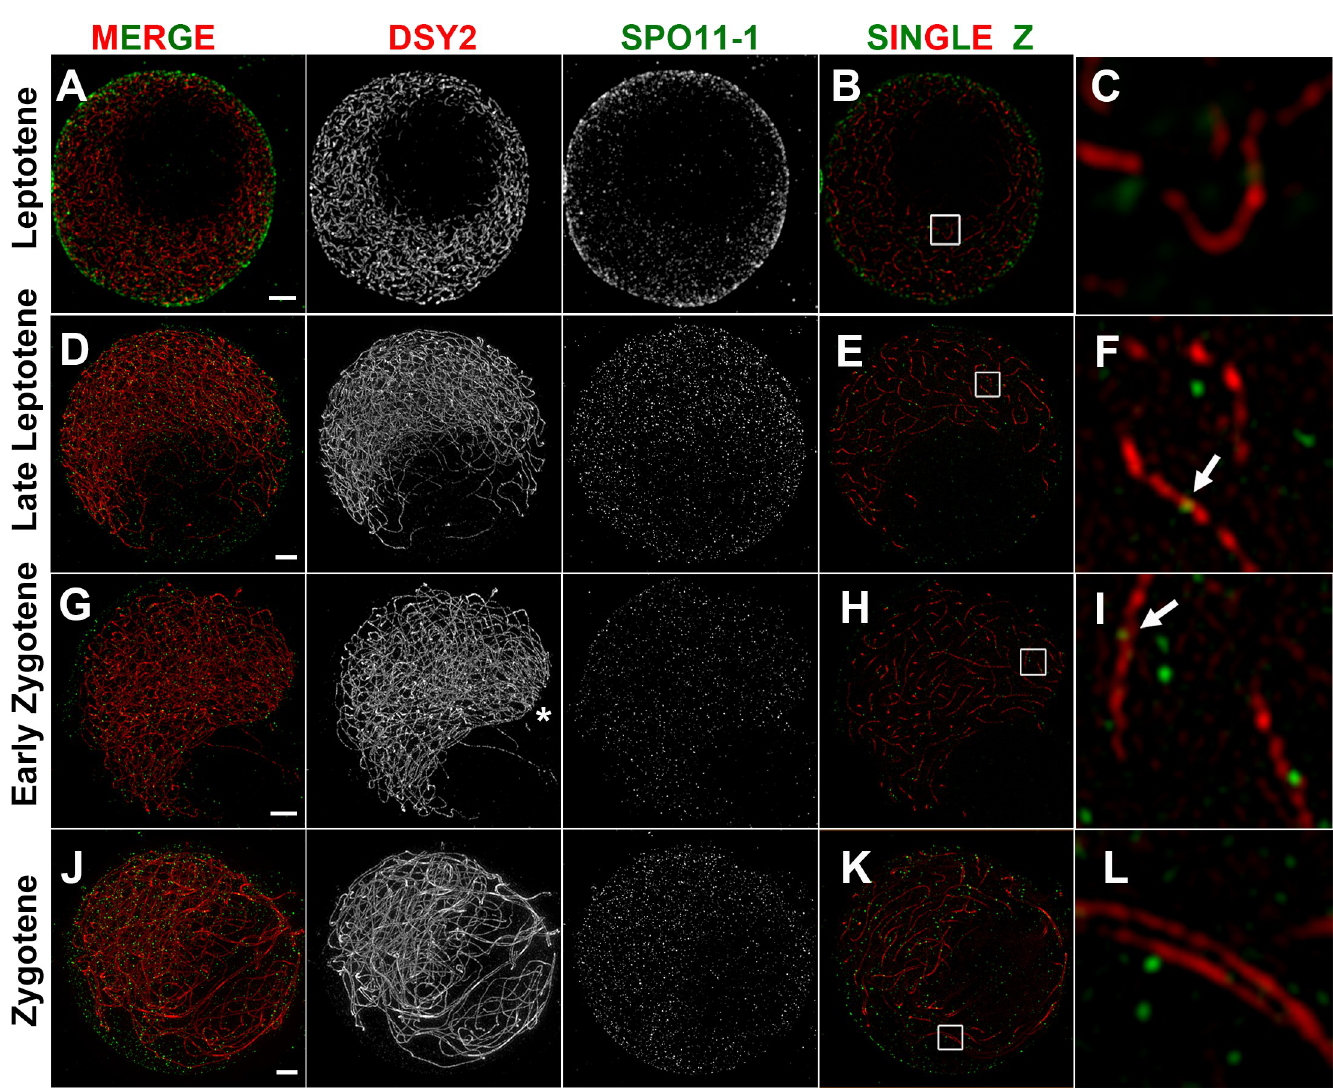
Fig 5. SPO11-1 localization revealed by super-resolution microscopy in wild-type. Super-resolution images of SPO11-1 (green) and DSY2 (red) staining in WT meiocytes shown as projection images of nuclei (A, D, G, J), single Z sections (B, E, H, K), and magnified views of 2 μ m 2 regions (C, F, I, L). Scale bars represent 2 μ m. Respective serial Z sections are shown in S8–S11 Figs. (A-C) A leptotene nucleus with long and intricate chromosome axes surrounding a nucleolus exhibiting most of its SPO11-1 foci around the nuclear periphery and less signal within the nucleus. (D-F) A late leptotene nucleus with an off-set nucleolus exhibiting numerous SPO11- 1 foci distributed within the nucleus. No obvious pre-alignment of axes was observed (S9 Fig). Some SPO11-1 foci are located on DSY2-labeled AEs (arrow). (G-I) An early zygotene nucleus with telomere bouquet (asterisk) and pre-aligned axes (Z11-19 in S10 Fig) exhibiting numerous SPO11-1 foci. Note that the nucleolus exhibits less SPO11-1 signal. (J-L) A zygotene nucleus with progressive pairing and synapsed regions containing numerous SPO11-1